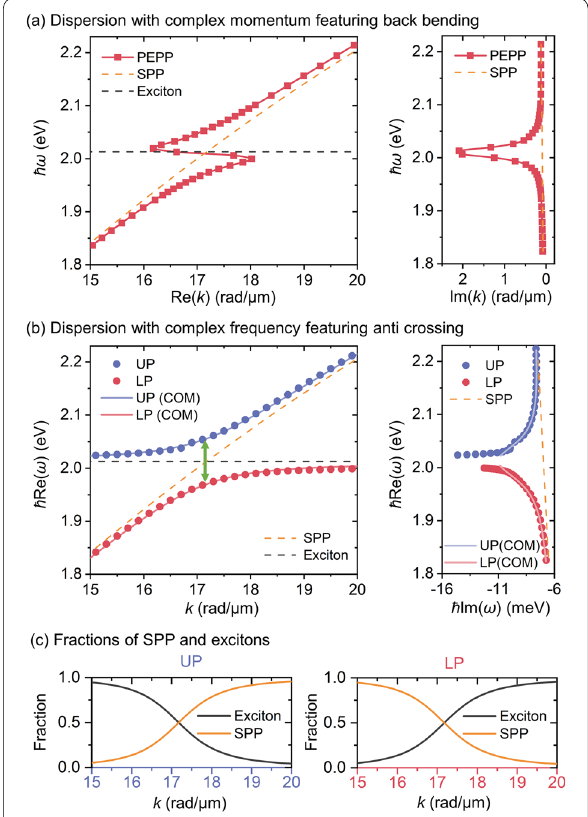
Fig. 2 Strong coupling between excitons and SPPs in a WS 2 -clad Ag MNW. a Solutions in the complex-momentum (complex- k ) plane by feeding real-valued ω . Left: dispersion relation in terms of ħω vs. Re( k ) featuring back-bending. Right: trajectories of ħω and Im( k ). Red squared, yellow dashed, and black dashed lines: PEPP, SPP, and excitons. b Solutions in the complex frequency (complex- ω ) plane by feeding real-valued k . Left: dispersion relation in terms of ħ Re( ω ) versus k featuring anti-crossing. Right: trajectories of ħ Re( ω ) and ħ Im( ω ). The numerically obtained result for the PEPP is denoted by blue (upper branch, UP) and red dots (lower branch, LP), showing excellent agreement to the result obtained from the coupled-oscillator model (COM, blue and red lines) with a Rabi splitting energy ~ 85.7 meV (green arrow). Yellow and black dashed lines: SPP and excitons. c Fractions of excitons (black lines) and the SPP (yellow lines) in the PEPP. Left: upper branch. Right: lower branch. The diameter for Ag MNW here is 50